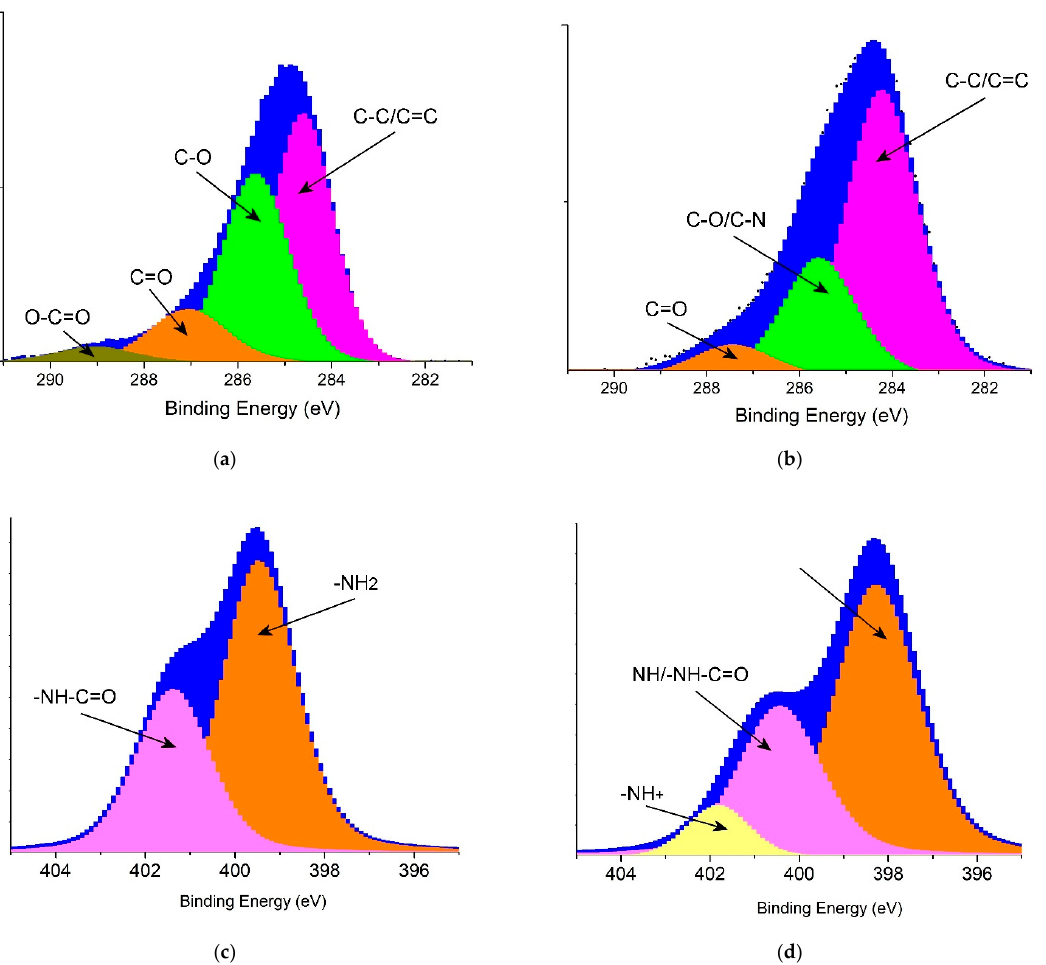
Figure 3. X-ray photoelectron spectroscopy spectra of adsorbents: ( a ) C1s of PPSH, ( b ) C1s of PANI@PPSH, ( c ) N1s of PPSH and ( d ) N1s of PANI@PPSH.